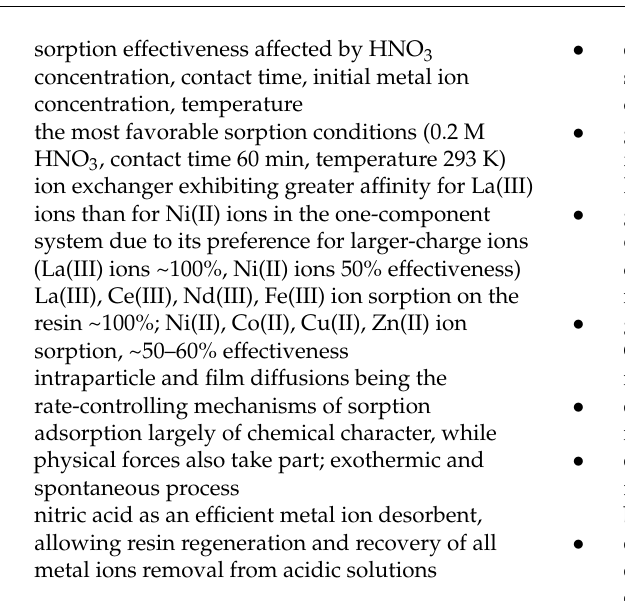
Table 2. Cont . Major Findings Process Intensification Achieved